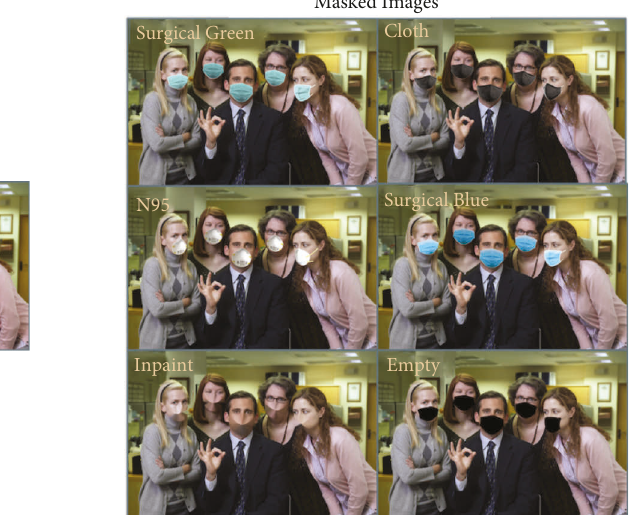
Figure 17: Example of the image before and after running MaskTheFace